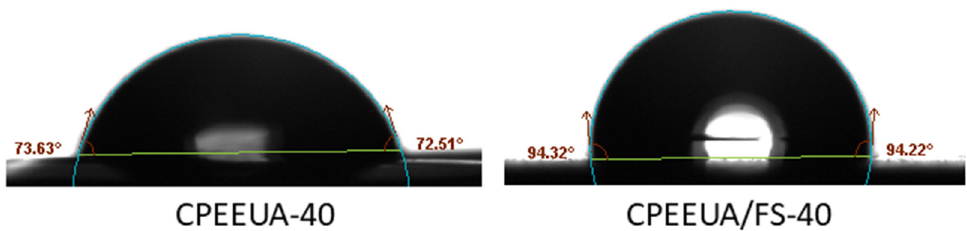
Figure 4. Contact angle of CPEEUA-40 and CPEEUA/FS-40 to evaluate hydrophobicity.